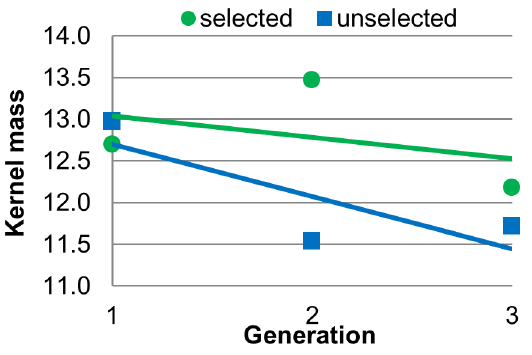
Fig 6. Effect of selection on kernel mass. Data points are mean 50-seed mass (grams) versus generation, shown with the linear regression trend lines. The equations of the lines for selected and unselected populations are y = -0.2559x + 13.294 (R 2 = 0.1554) and y = -0.6242x + 13.325 (R 2 = 0.6387)